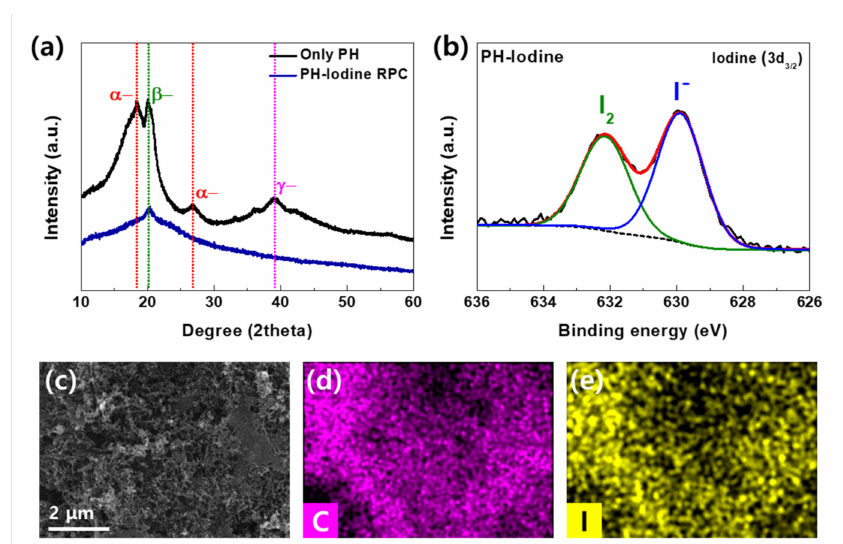
Figure 2. Structural analysis of the samples. ( a ) XRD patterns of the samples. ( b ) XPS spectra of I 3d for the PH-Iodine RPC sample. ( c ) FE-SEM and ( d , e ) EDX mapping images of the electrode of the PH-Iodine RPC